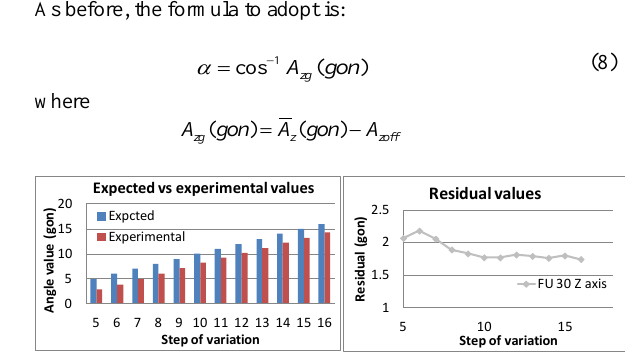
Figure 11. Tilt values one axis z mode. Expected vs experimental values (left) - residual